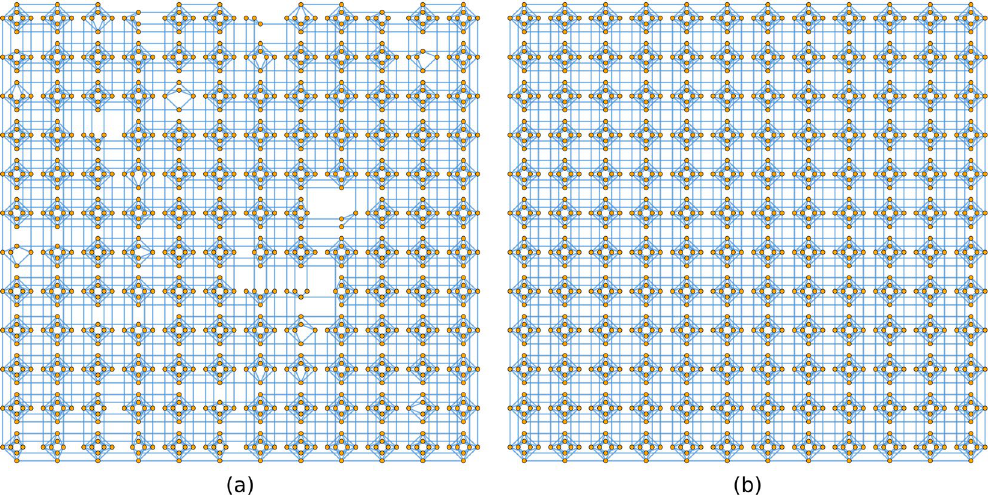
Figure 2. ( a ) The physical hardware graph associated with the D-Wave 2X at Los Alamos National Laboratory and ( b ) the associated Chimera graph are shown. Each vertex in the graph represents a bit and each edge in the graph indicates that the two associated bits can be coupled. Note that (a) is obtained from (b) by removing some vertices and edges.